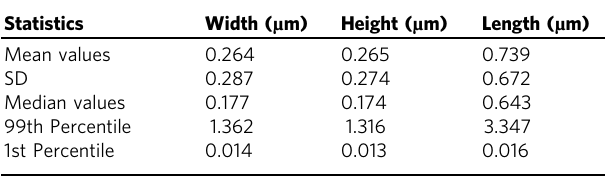
Table 2 Three-dimensional size distribution of 100 nm PSL spheres in the aerosol